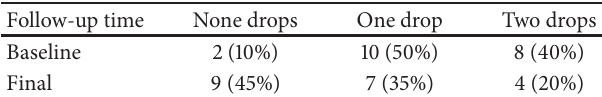
medications, while six patients were medication-free